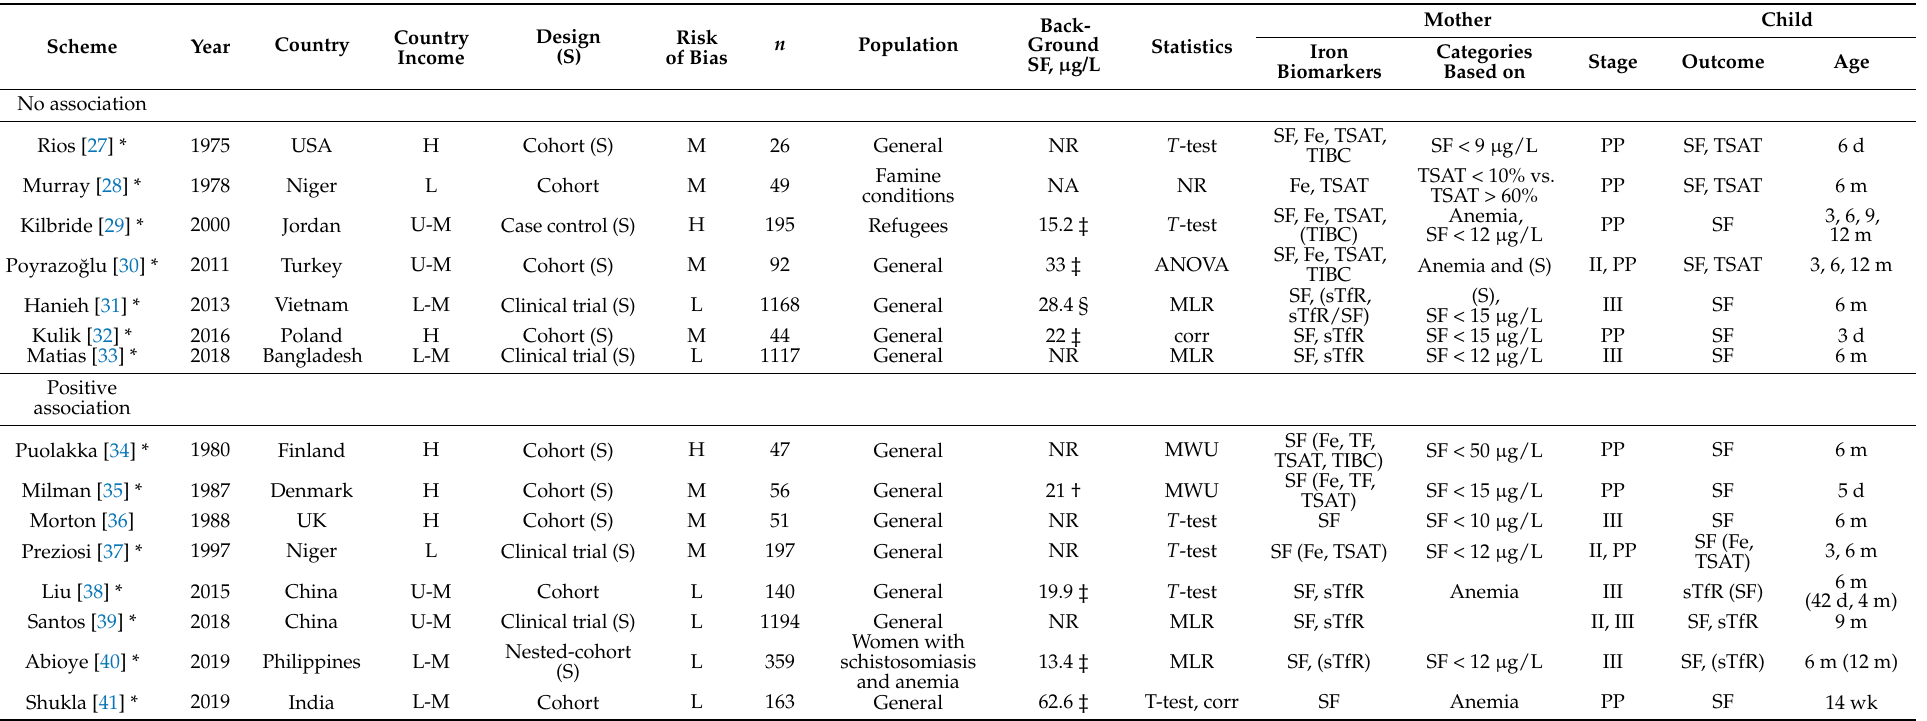
Table 1. Studies on maternal iron status and child iron status after